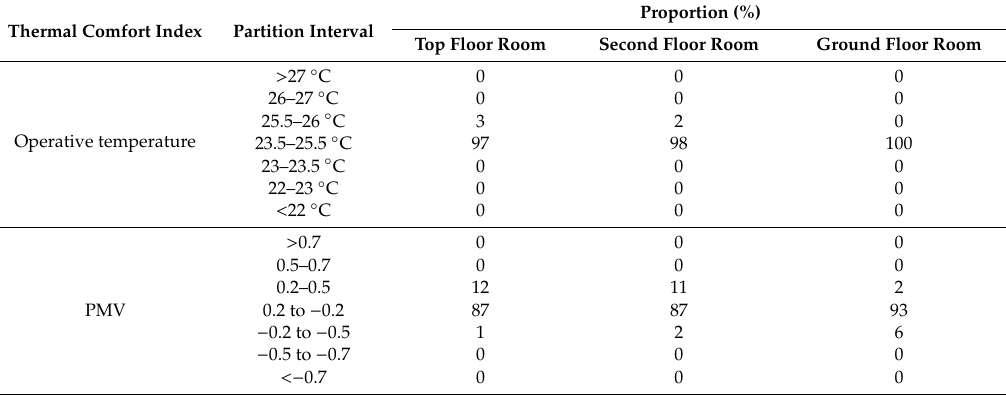
Table 6. Proportions of time that different operating temperature and PMV intervals occur under the scheme using Equation (2).